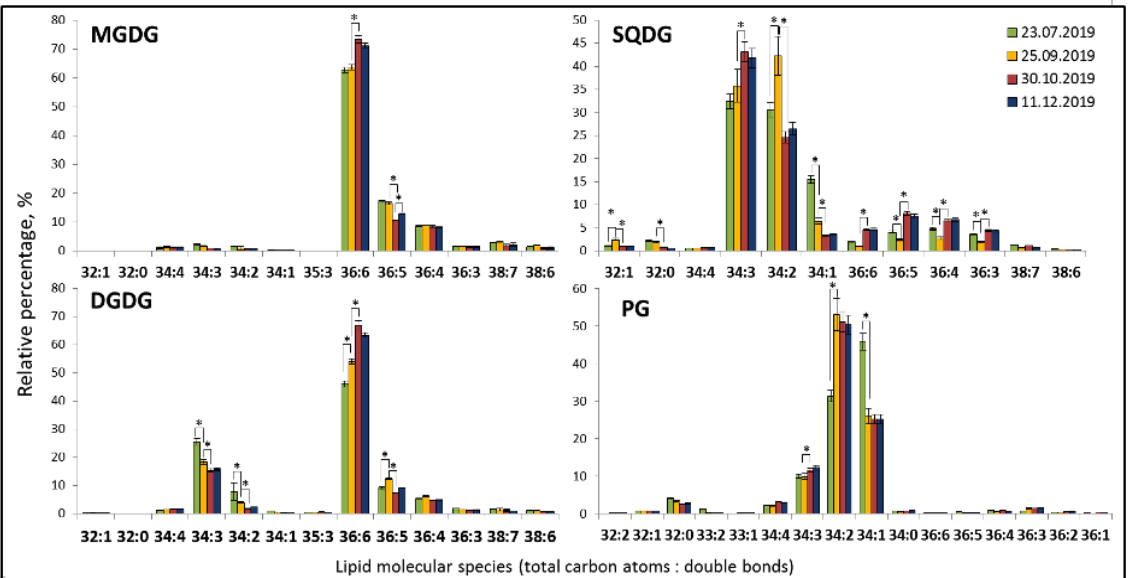
Figure 4. Seasonal changes in plastidic lipid molecular species in Ephedra monosperma . MGDG — monogalactosyldiacylglycerols; DGDG — digalactosyldiacylglycerols; SQDG — sulfoquinovosyldiacylglycerols; PG — phosphatidylglycerols. Bars represents standard deviations. * — significant differences according to Student’s t -test.